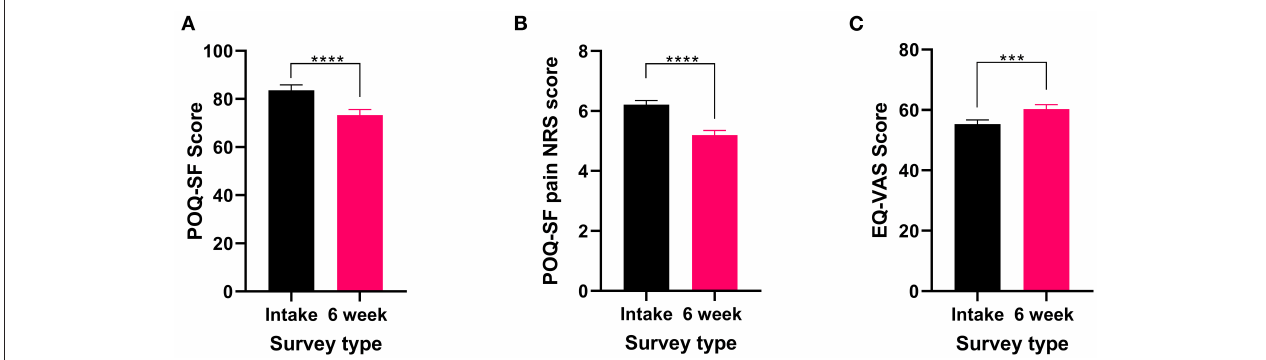
FIGURE 1 | Validated survey scores from the intake survey (baseline) and the 6-week follow-up survey for patients reporting recurrent pain. Overall POQ-SF, pain NRS score and the five subscales of the POQ-SF (see Supplementary Figure 2 ), showed improvements after 6 weeks of medical cannabis treatment. (A) Overall POQ-SF score significantly decreased after 6 weeks of medical cannabis treatment ( t 182 = 6.74 P < 0.0001). (B) The pain NRS score reduced significantly (Wilcoxon test P < 0.001) from 6.2 ± 1.8/10 at baseline to 5.2 ± 2.1/10 at the 6-week follow-up. (C) EQ-VAS score significantly improved from the intake survey to the 6-week